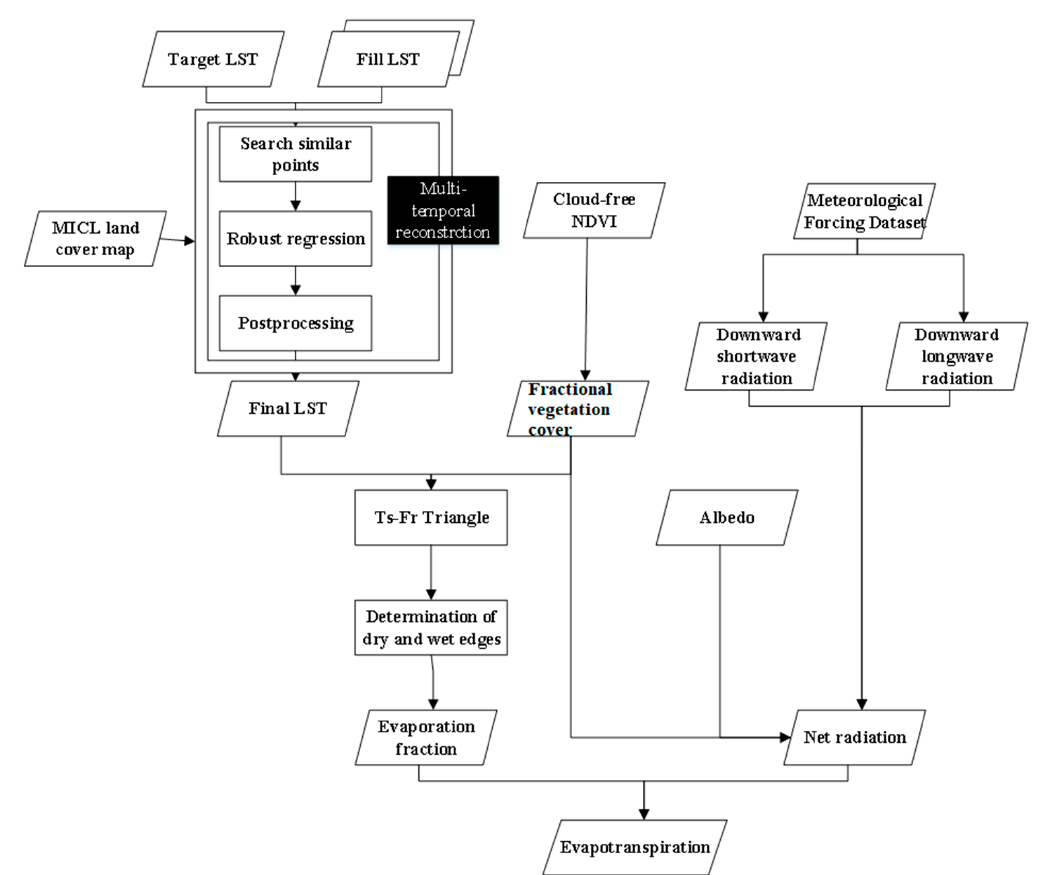
Figure 2. Flow chart of the proposed algorithm to estimate evapotranspiration, where LST: land surface temperature; Ts-Fr: surface temperature-fractional vegetation cover; NDVI: normalized difference vegetation index; MICL: multi-source information-based China landcover.